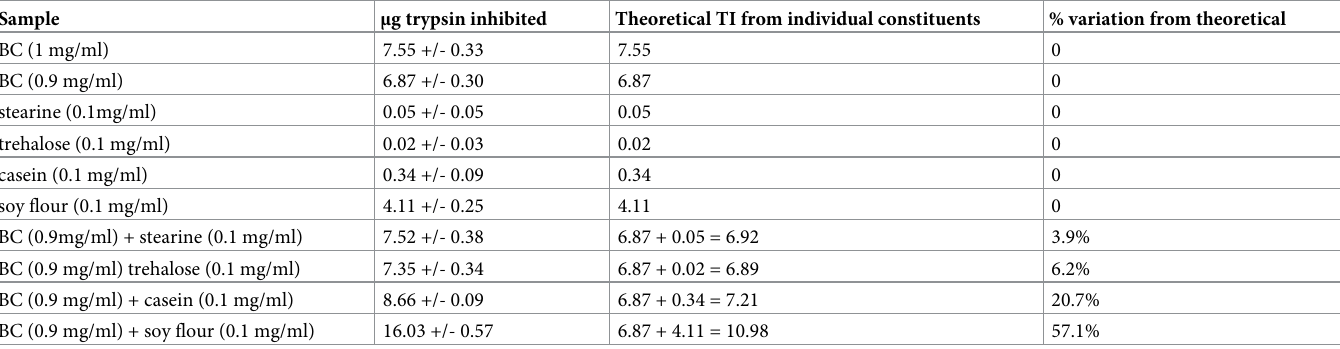
Samples were analysed in quadruplicate with appropriate blanks. Results expressed as mean +/-